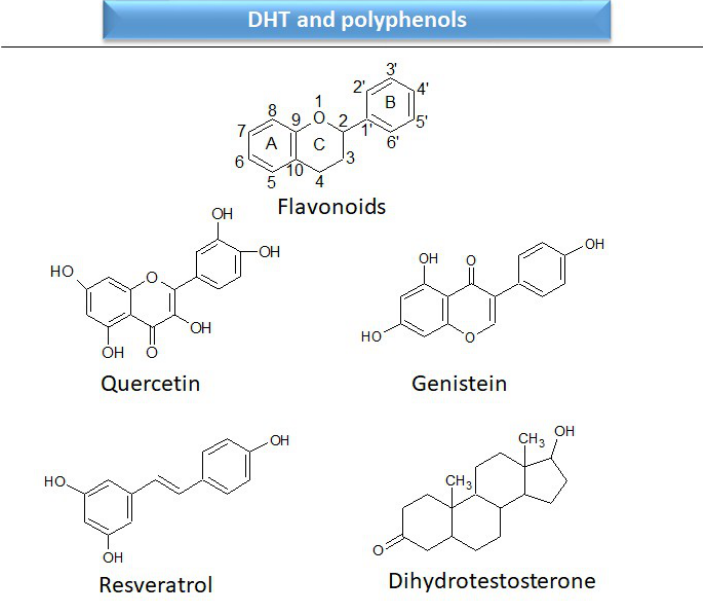
Figure 2. Chemical structures of some polyphenols that display similarities to dihydrotestosterone